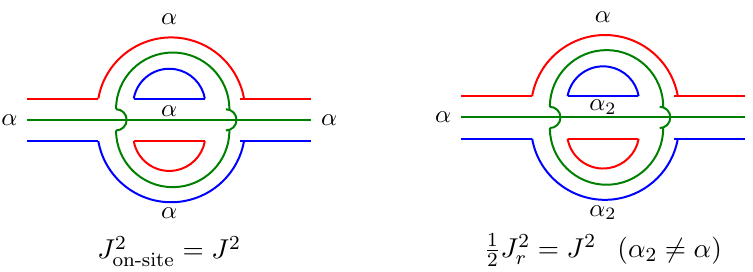
Figure 4. Contribution to the Schwinger-Dyson equation for the two point function.